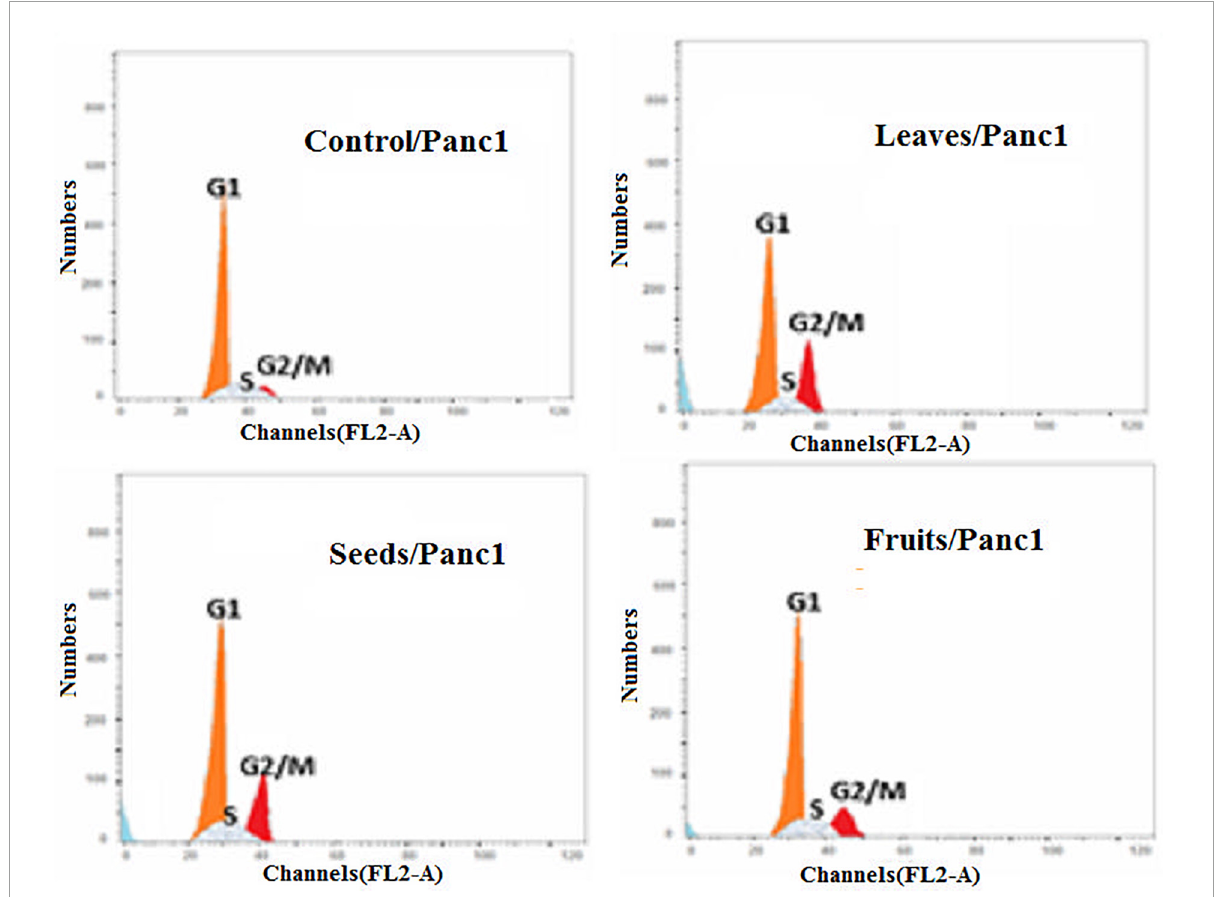
FIGURE12 Cell cycle analysis after treatment of Panc1 cells with leaf, seed, and fruit extracts separately in comparison with control.